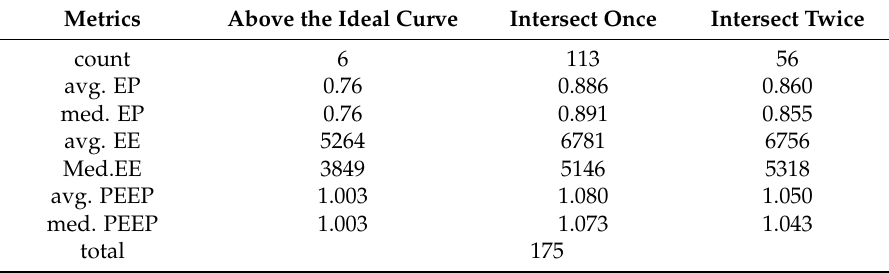
Table 3. Energy efficiency and proportionality of servers with non-100% peak energy